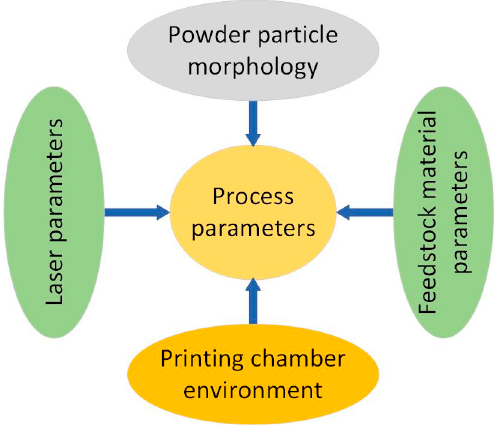
Figure 2. The source of process parameters for